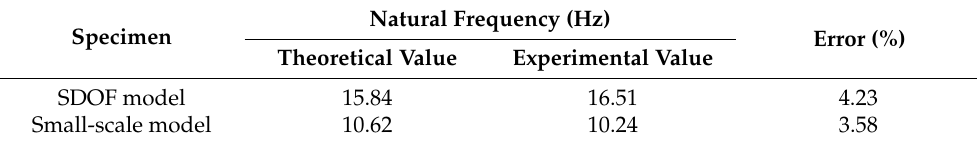
Figure 11. Time history curve of the small-scale model by sinusoidal forced vibration test: ( a ) first test; ( b ) second test; ( c ) third test; ( d ) fourth test; ( e ) five test; ( f ) overlapping entire tests.